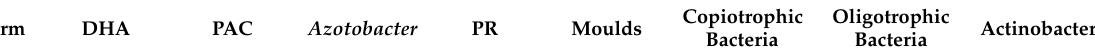
Table 4. Correlation coefficients between the quantitative traits of spring wheat observed at the five terms. * p < 0.05; ** p < 0.01; *** p <